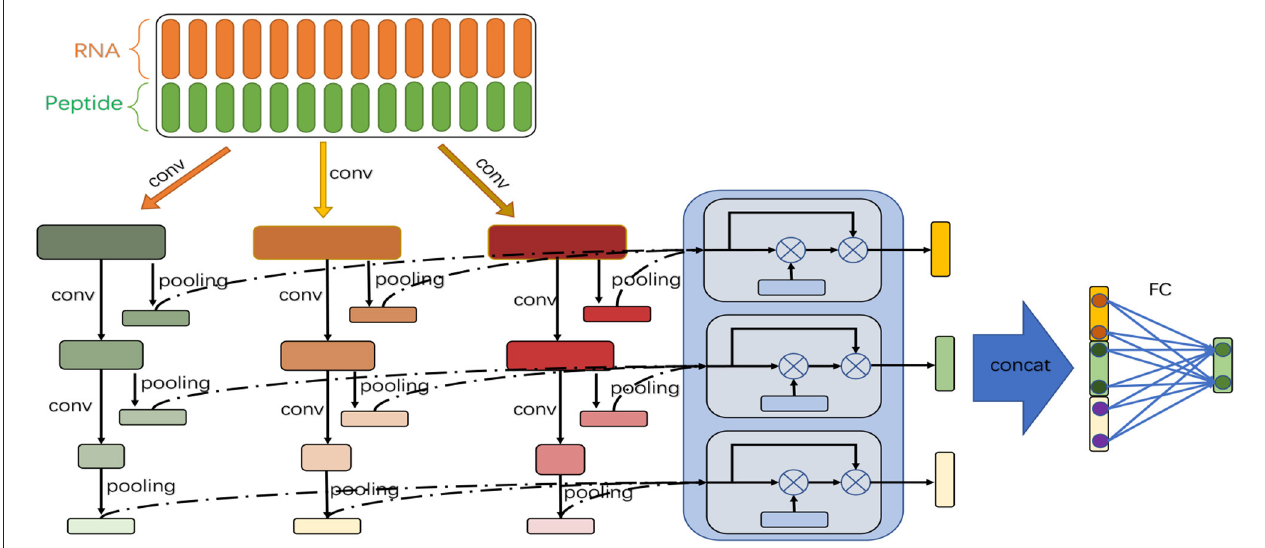
FIGURE 1 | Model architecture of DeCban. The network consists of three convolutional layers and three branches (shown in green, orange, and red, respectively). An attention layer (shown in light blue) is used to integrate the outputs of the three branches. Then, the feature embeddings learned by the three layers are concatenated and fed to a fully connected layer to yield the final output.